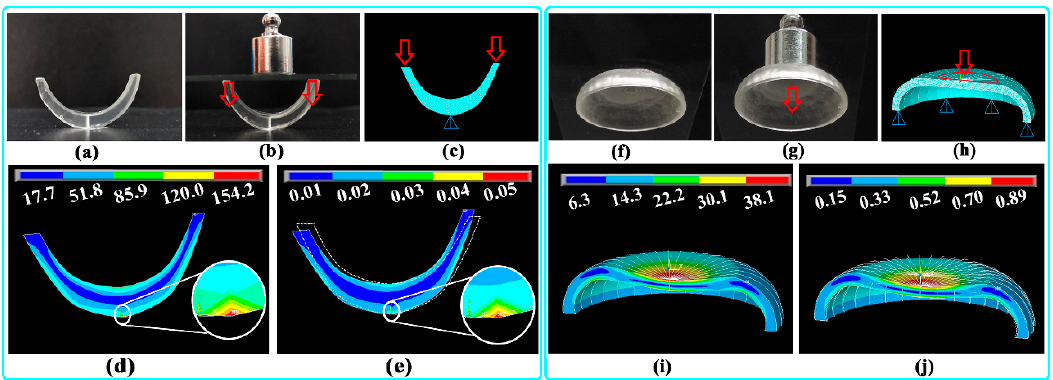
Figure 10. Typical U-shaped sample: ( a ) before and ( b ) after compression; ( c ) mesh model with loaded pressure; simulated ( d ) Von Mises stress ( σ v ) and ( e ) Von Mises strain ( ε v ) distribution. Typical arc-shaped sample: ( f ) before and ( g ) after compression; ( h ) mesh model with loaded pressure; simulated ( i ) σ v and ( j ) ε v distribution.